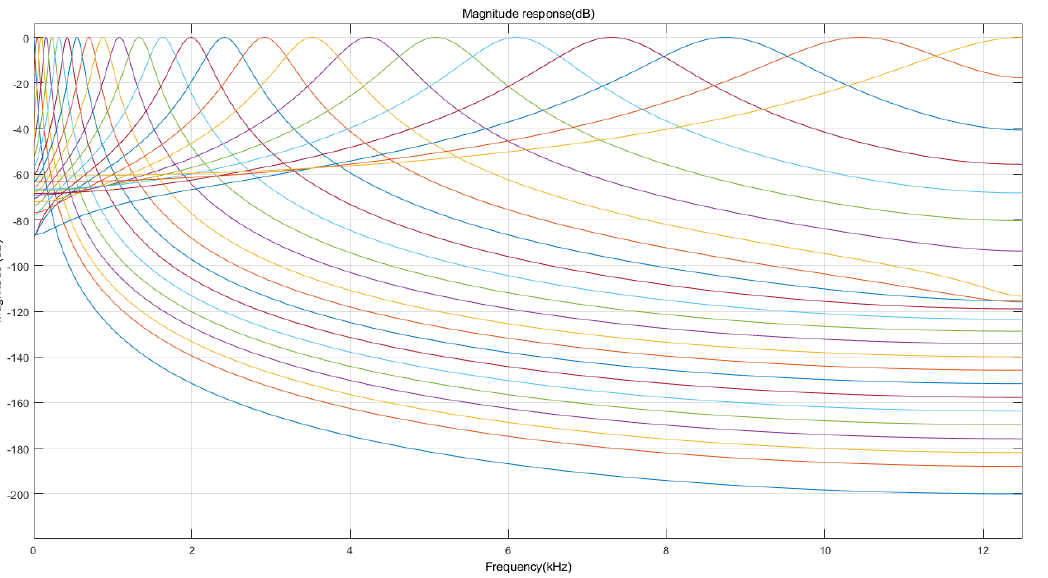
Figure 1. The framework of MRQMs extraction for pathological voice detection and classification.